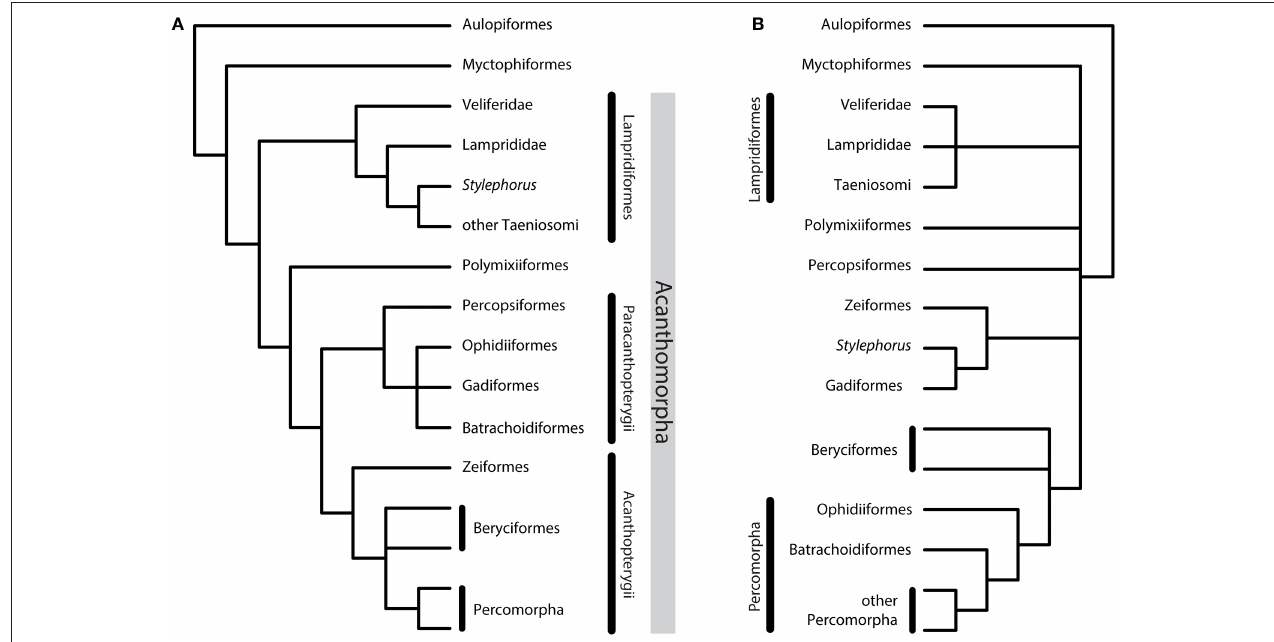
FIGURE 1 | Consensus of the phylogenetic hypotheses for Acanthomorpha, summarizing previously published results. (A) Morphological hypothesis ( Patterson and Rosen, 1989; Johnson and Patterson, 1993; Olney et al., 1993). (B) Molecular hypothesis based on the latest large-scale acanthomorph